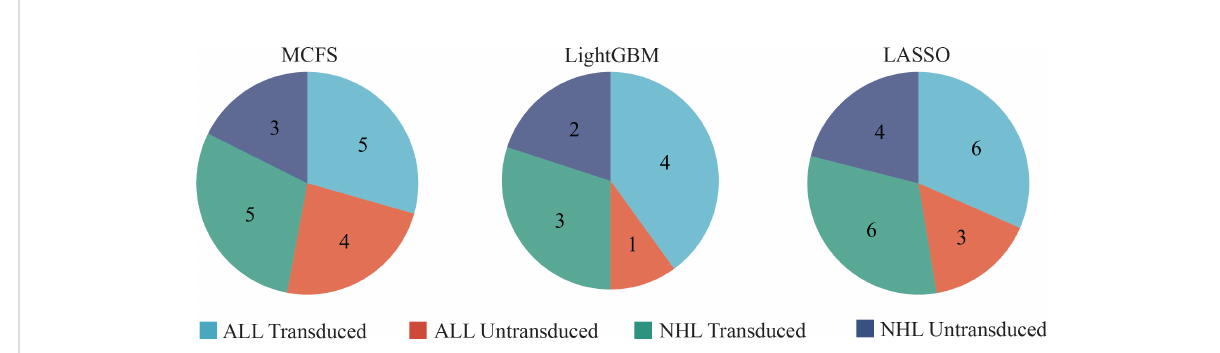
FIGURE 7 The number of rules extracted from the decision tree built on feature lists yielded by MCFS, LightGBM, and LASSO, respectively, on four